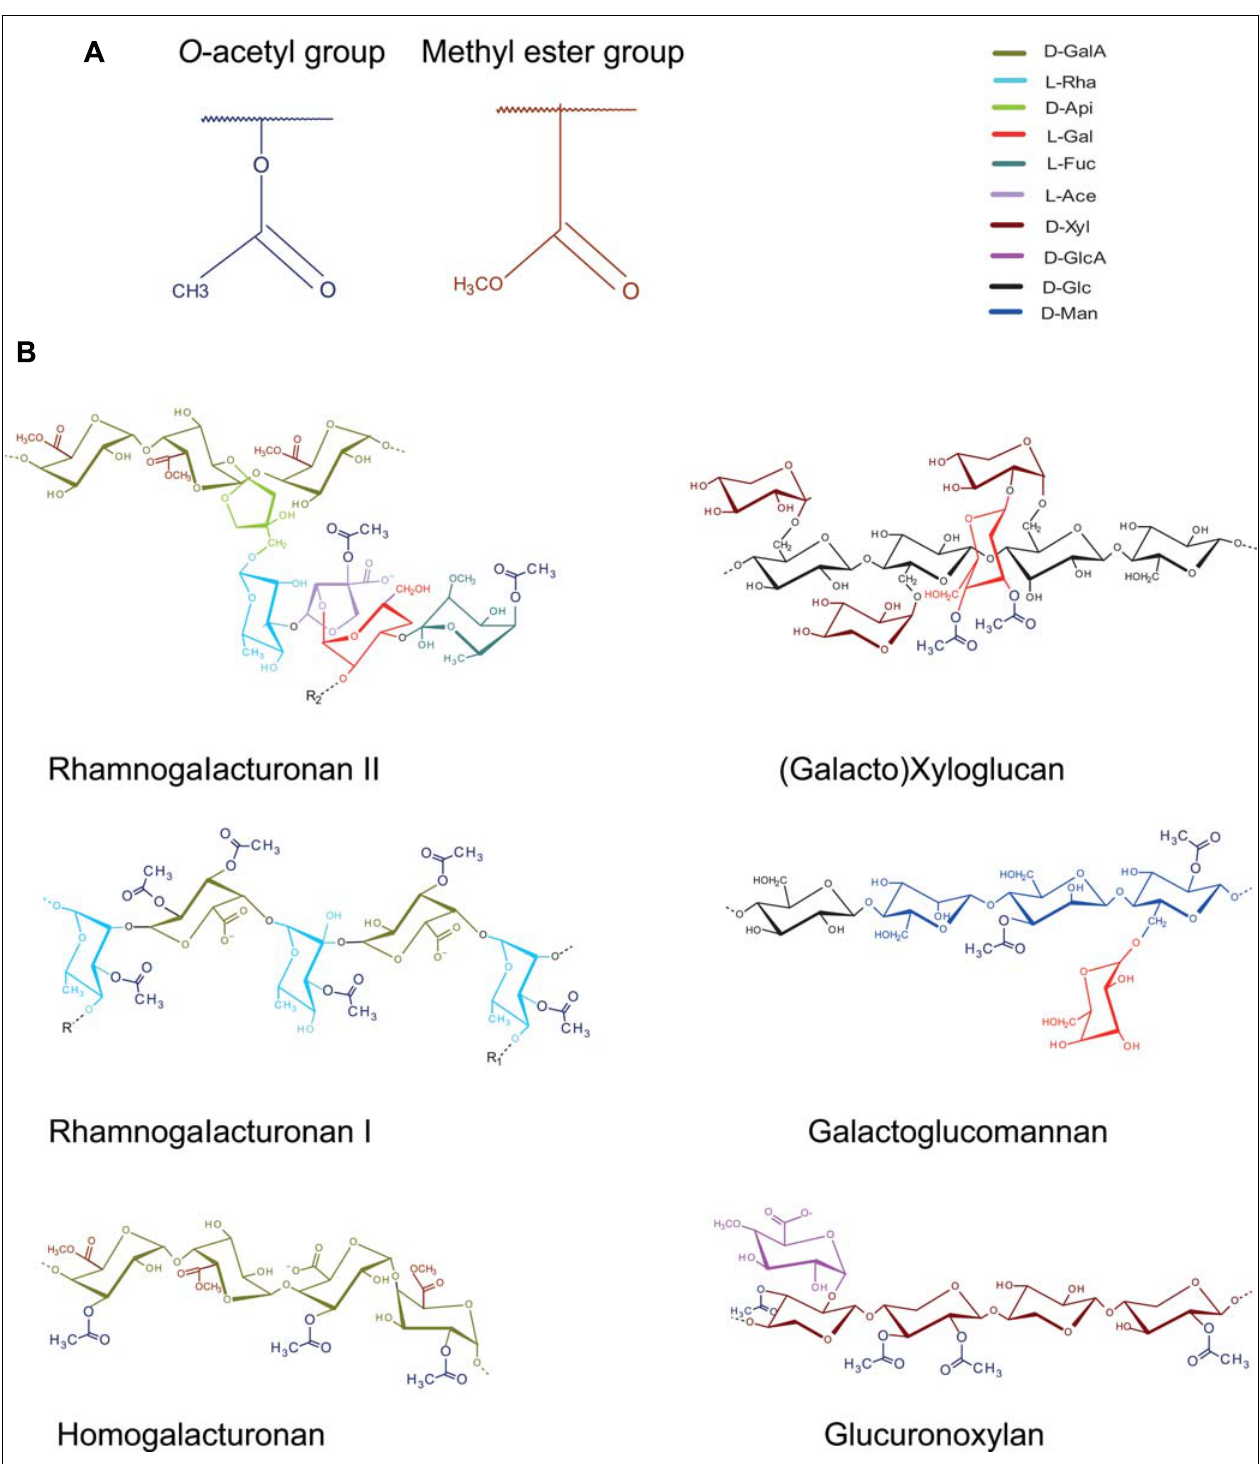
acid. (B) Occurrence of O- acetyl groups in cell wall matrix polysaccharides (Voragen etal., 1986; Pauly and Scheller, 2000; MacKinnon etal.,